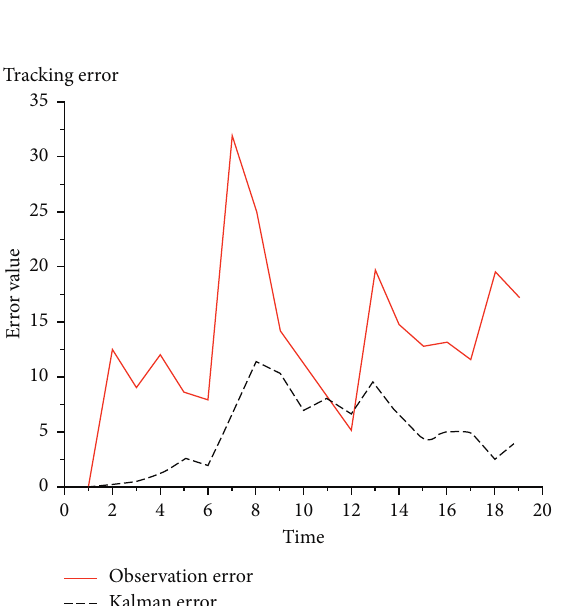
Figure 2: Ship tracking trajectory.